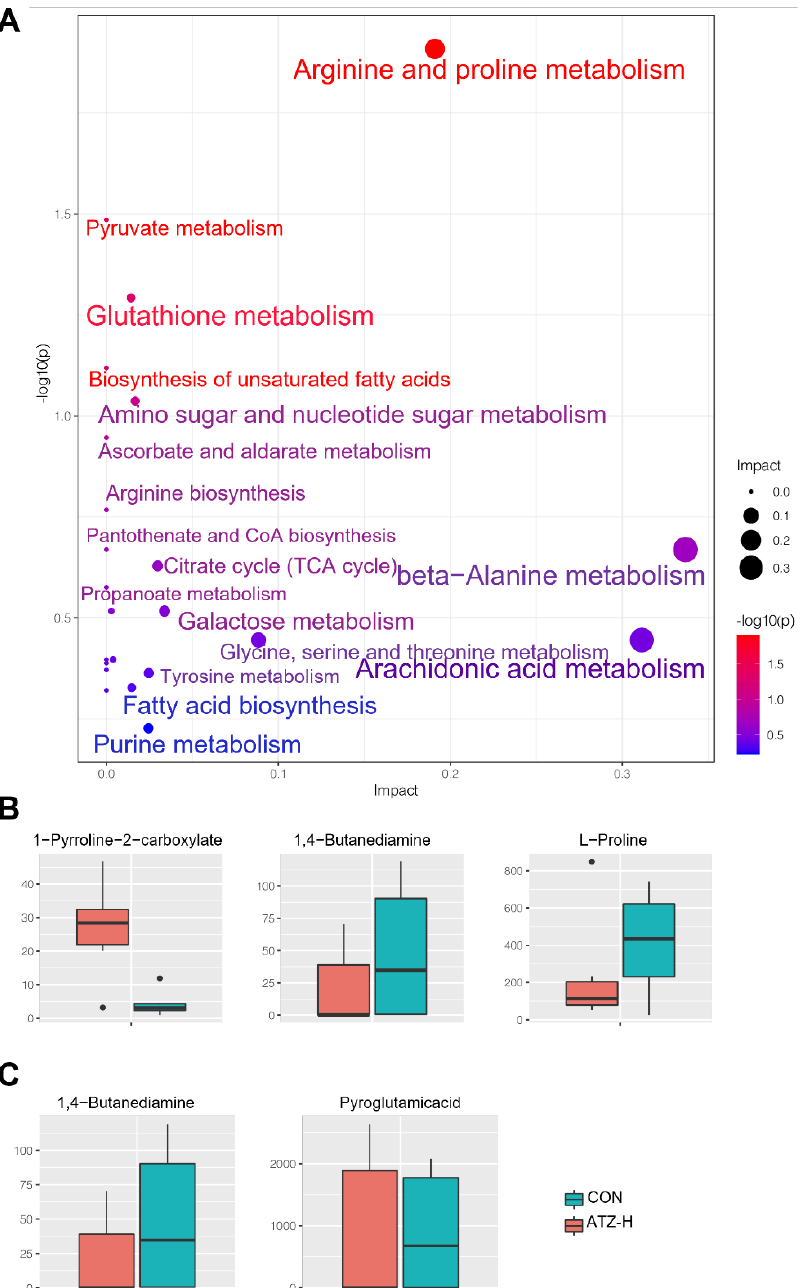
Figure 3. ATZ exposure induced enrichment and changes in different pathways of altered metabolites in zebrafish liver. ( A ) Pathway enrichment of some altered metabolites in the liver of zebrafish after 21 days of ATZ exposure. ( B ) Metabolites with major changes in the metabolic pathway of arginine and proline. ( C ) The main metabolites that change in the metabolic pathway of